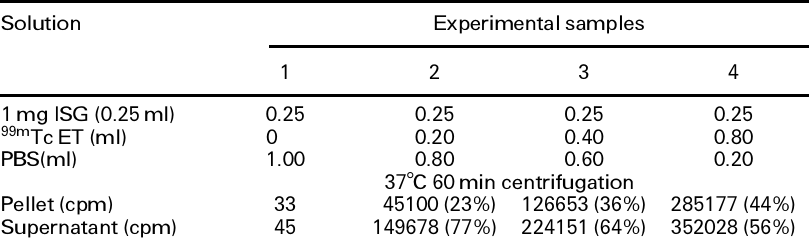
Table 2. Binding of 99m Tc E. coli lipopolysaccharide (endotoxin, ET) by 1 mg of insoluble glycogen (ISG). Data represent the average values of two repeated binding experiments with duplicated samples ( n = 4)